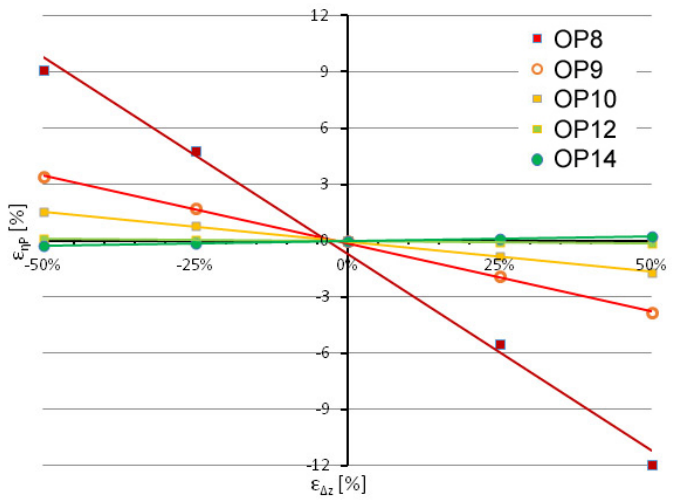
Figure 12. Algorithm sensitivity analysis regarding the determination of the pump efficiency (cid:101) η deviations in the input of the level difference (cid:101) ∆ z between the locations of the transducers at suction and at discharge for the five operating points: OP8, OP9, OP10, OP12 and OP14.